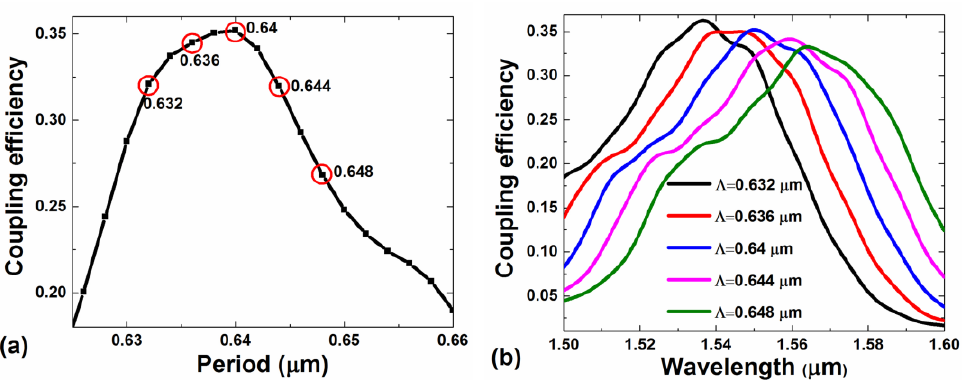
Figure 6. ( a ) Coupling efficiency as a function of period. ( b ) Coupling efficiency as a function of wavelength for different period.